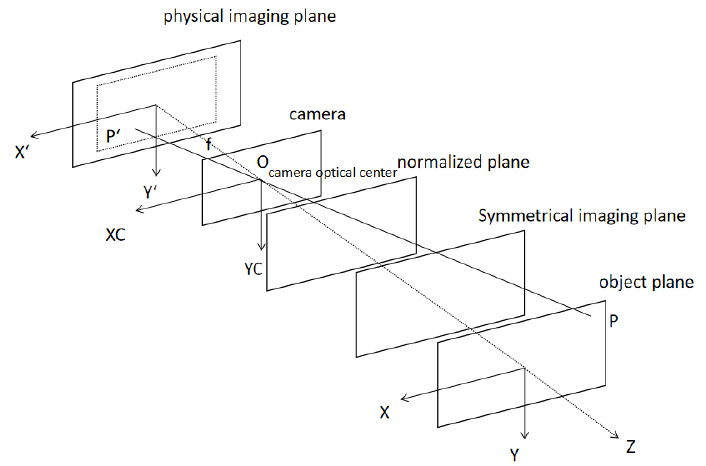
Figure 1. Position diagram of a coordinate system in a camera imaging model.